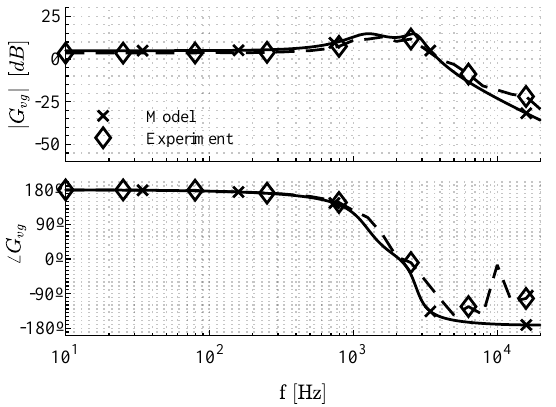
Figure 9. Bode plot comparison of audio susceptibility at D = 0.7. The results obtained from the small-signal line-to-output transfer function is compared with that of the one obtained from the experimental test